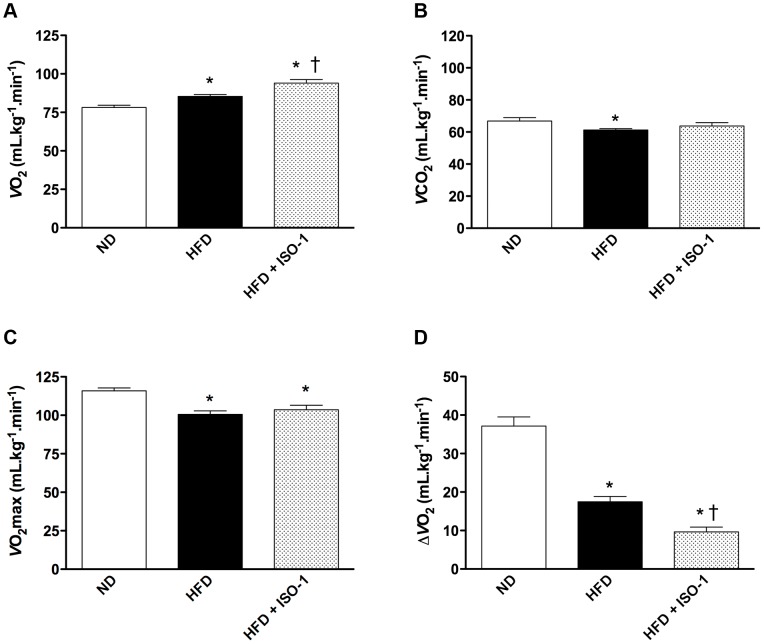
ISO-1 reduced aerobic capacity. (A) Basal VO2 and (B) VCO2 measured by indirect calorimetry.(C) Maximal VO2 (VO2max) obtained from mice subjected to treadmill exercise. (D) Difference between VO2 and VO2max (ΔVO2) in ND, HFD and ISO-1-treated HFD mice. n = 6–10, *p<0.05 vs. ND, †p<0.05 vs. HFD.